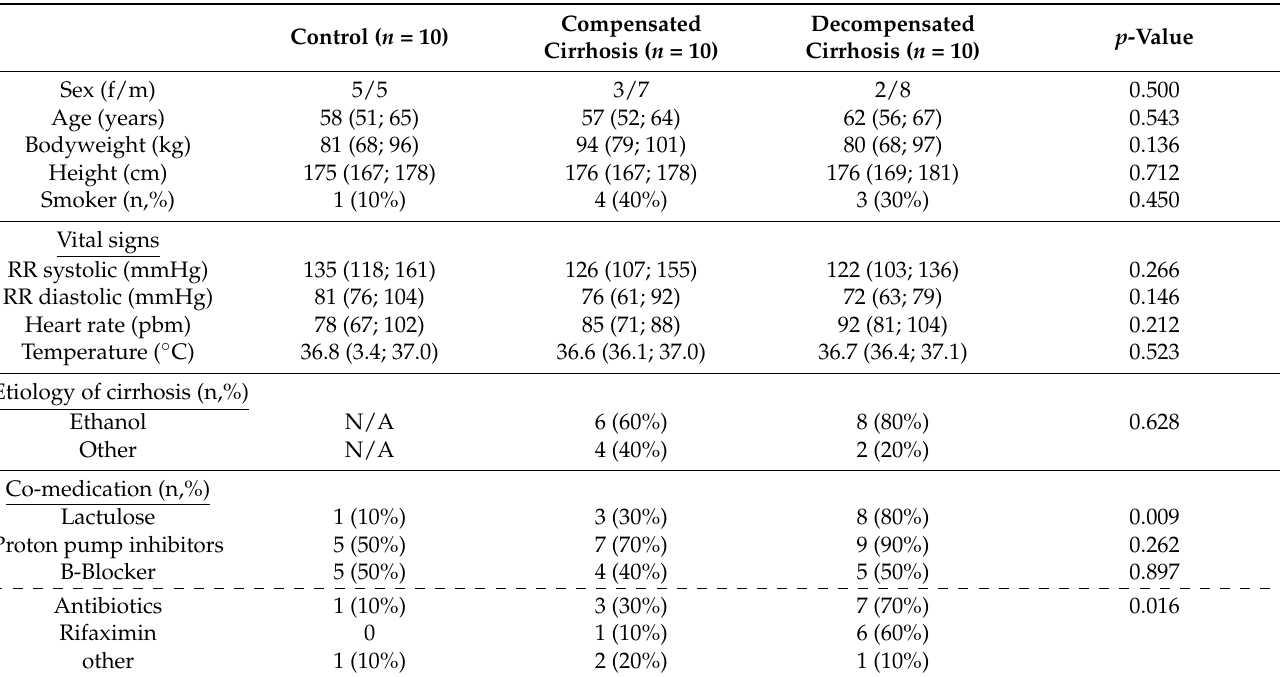
Table 1. Patient data (values in parentheses represent the respective minimum and maximum values or describe percentages). Compensated Decompensated Control ( n = 10) Cirrhosis ( n = 10) Cirrhosis ( n =